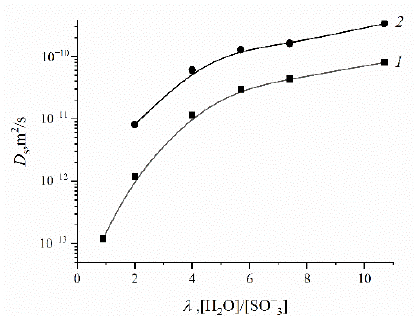
Figure 22. Self-diffusion coefficients of Li + ion (curve 1) and water molecule (curve 2) dependences on the water content λ in the Nafion 117 membrane Li + ionic form, where λ is the water amount per sulfonate group. Reprinted with permission from Ref. [60]. Copyright © 2022 Elsevier B.V. All rights reserved.